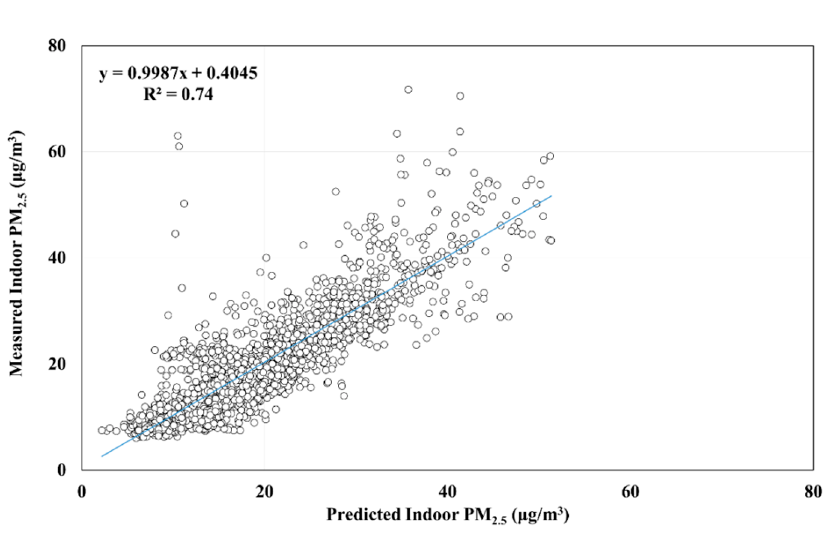
Figure 2. Relationship between predicted and measured hourly average indoor PM 2.5 concentration according to the multiple linear regression model.